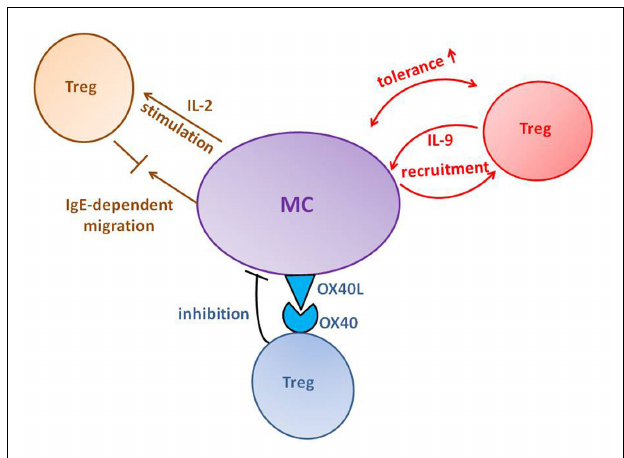
FIGURE 2 | Proposed paradigms ofTreg–mast cell (MC) interaction. Several modes of interaction have been described forTreg effects on MC activation and for the cross-talk between the two cells (from top left clockwise): Failure ofTreg-mediated IgE suppression enhances MC migration and IL-2 production in the spleen which, in turn, boostsTreg activity;Treg–IL-9 production recruits MC to skin allografts where the two cells collaborate to create tolerance; engagement of OX40L and OX40 results in inhibition of MC degranulation and dampening of